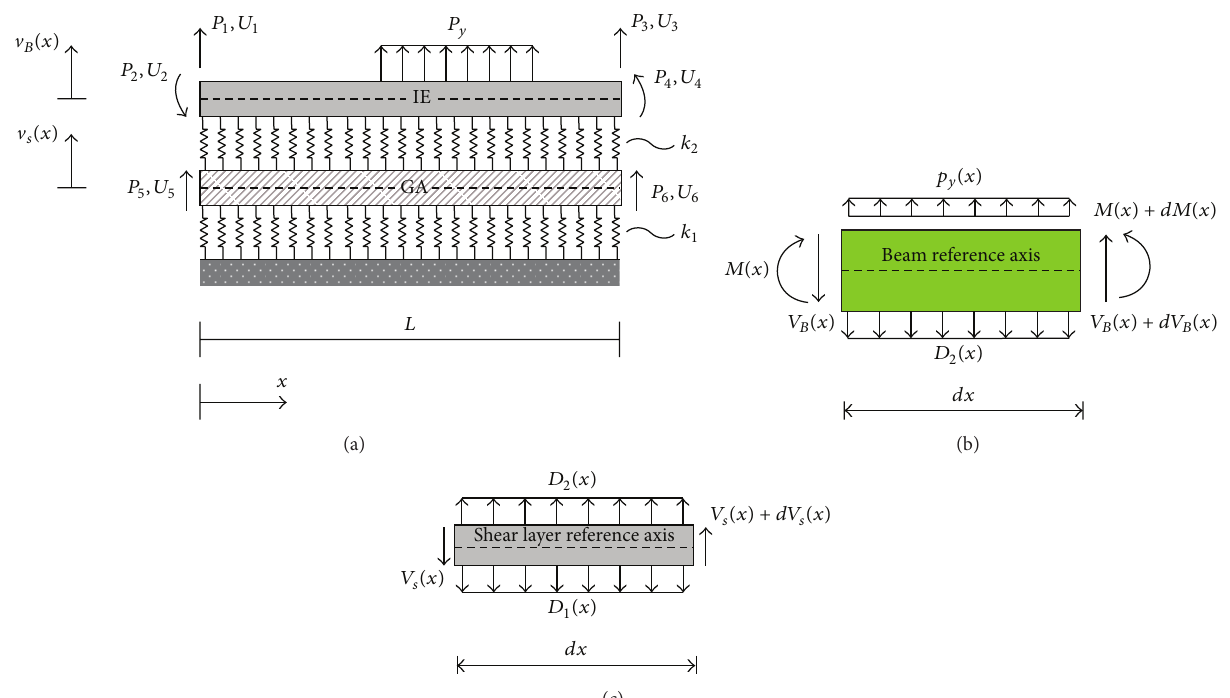
Figure 1: (a) A beam on Kerr-type foundation; (b) a differential segment cut from the beam; (c) a differential segment cut from the shear